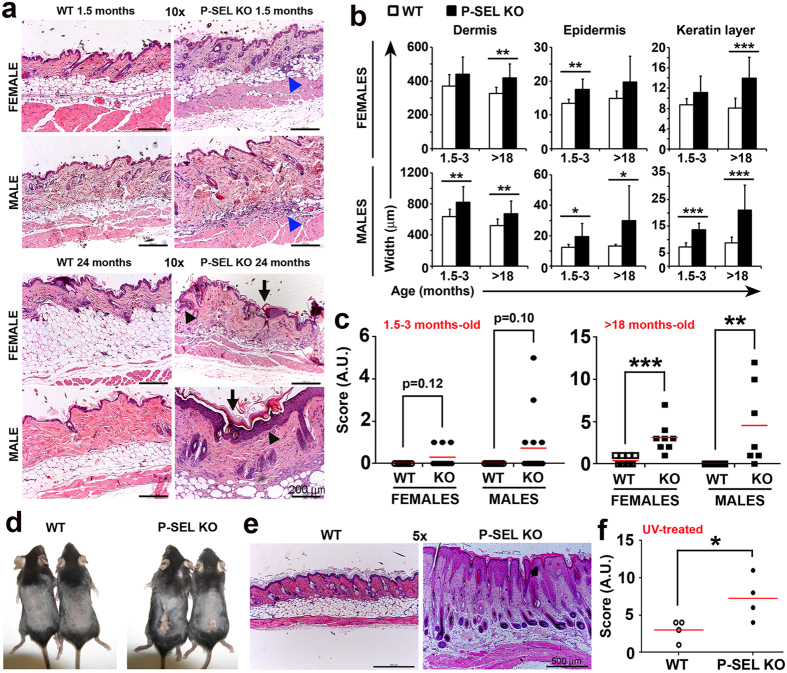
Histological alterations in the skin of P-Sel−/− mice.(a) Photomicrographs (10×) of hematoxylin and eosin (H&E)-stained skin sections of 1.5 month-old (upper panels) and 24-month-old female and male WT and P-Sel−/− mice (lower panels). Blue arrowheads show panniculitis. Black arrowheads show acanthosis; arrows show hyperkeratosis and keratin plugs. Scale bars represent 200 μm. (b) Quantification of dermis, epidermis and corneal layer width of WT and P-Sel−/− mice. (c) Pathological activity index of skin samples obtained from WT and P-Sel−/− mice. (d) Lesions developed in the back of UV-irradiated 3-month-old female WT and P-Sel−/− mice. (e) Photomicrographs (5×) of representative skin sections of UV-irradiated 3-month-old female WT and P-Sel−/− mice. n = 4 mice per genotype. Representative experiment of three independent replicates. Scale bars represent 500 μm. (f) Pathological activity index of skin samples obtained from UV-irradiated 3-month-old female WT and P-Sel−/− mice. (b,c,f) Bars show the mean ± SD *p < 0.05; **p < 0.01; ***p < 0.005 by Student’s two tailed t test. n = 8–10 mice per genotype.